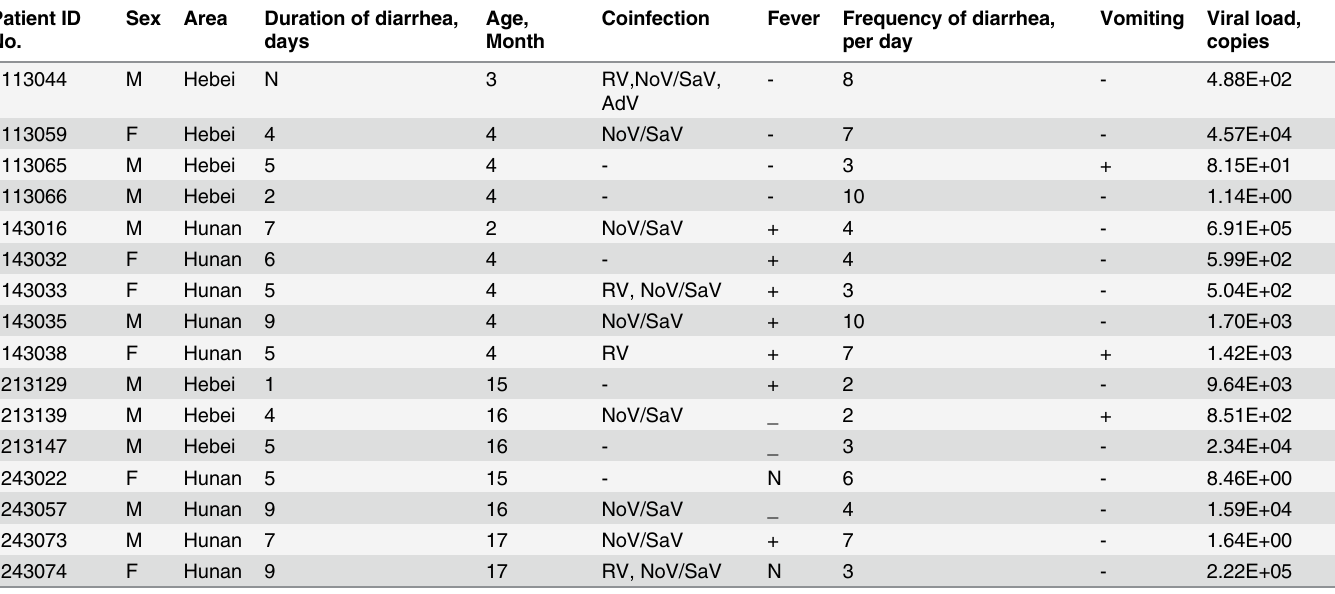
Table 1. Clinical characteristics, viral loads and related information of the 16 case children who were positive for salivirus. Patient ID